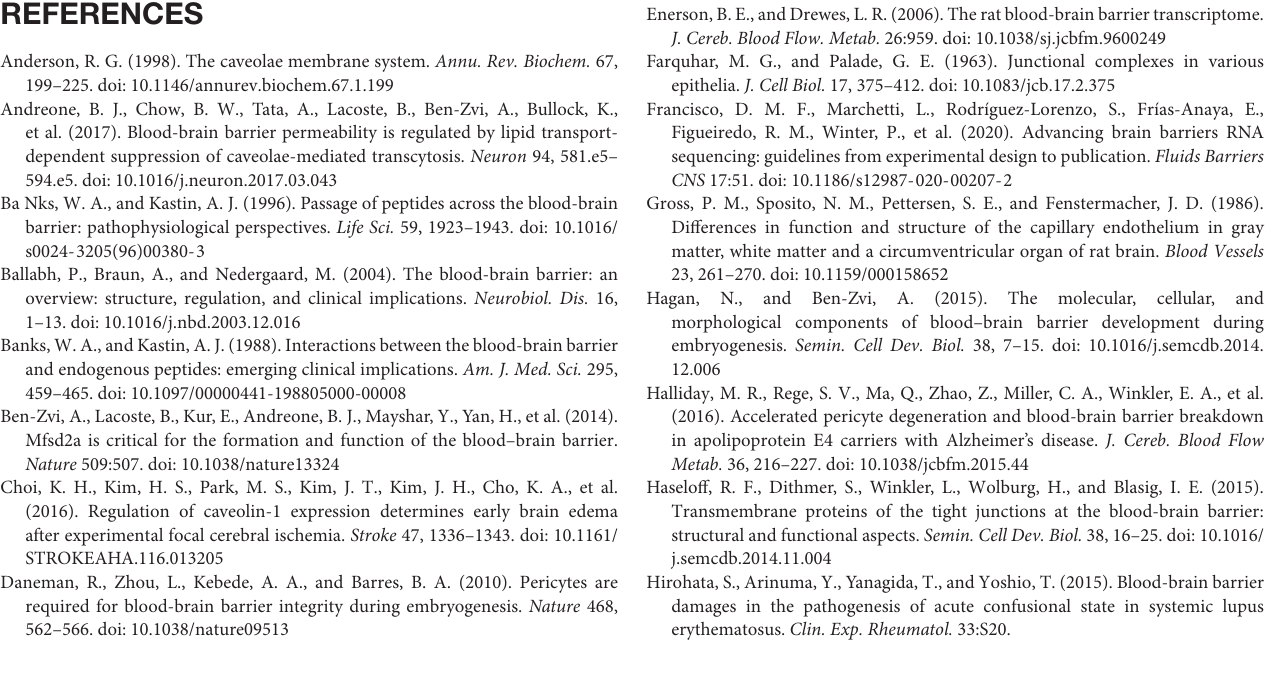
Supplementary Figure 1 | Overview of cortical microvascular purification protocol. (A) Separation of the cerebral cortex. After rat euthanasia, the thin slices of subdural meninges (SDM) on the dorsal surface of the brain were carefully removed using the dissecting microscope to validate the removal. The brain was horizontally cut in half, divided cautiously into cortex and internal structures. Then, it was dissected in cold phosphate-buffered saline (PBS). (B) Tissue shredding and digestion. The separated cerebral cortex was cut into 1 mm 3 tissue pieces and digested for 40 min. (C) Separation and purification of cerebral microvessels. Microvessel pellets were resuspended in a 20% BSA-V solution and centrifuged (4 ◦ C) for 8 min at 1,000 × g in order to remove the top layer, containing myelin and brain parenchymal cells. They were filtered with a 40 µ m cell strainer and centrifuged at 1,000 × g for 2 min to obtain pure pink microvessel fragments. After mixing them with 1 mL trizol, they were stored at − 80 ◦ C with liquid nitrogen. Supplementary Figure 2 | The 16 changed TJs genes in Venn diagram ( n = 3). Mean values ± SD, NS, not significant; * p < 0.05, ** p < 0.01, *** p < 0.001 and **** p < 0.0001 compared to the Sham group; one-way ANOVA followed by Dunnett’s post hoc test. Supplementary Figure 3 | (A) Rats were given an intraperitoneal injection of Evan’s blue dye, and their brain cortices were dissected the following day after PBS perfusion. (B) Quantification of EB at different timepoints. n = 10 per group; Mean values ± SD, NS, not significant; * p < 0.05, ** p < 0.01, *** p < 0.001 and **** p < 0.0001 compared to the 1-day group; one-way ANOVA followed by Dunnett’s post hoc